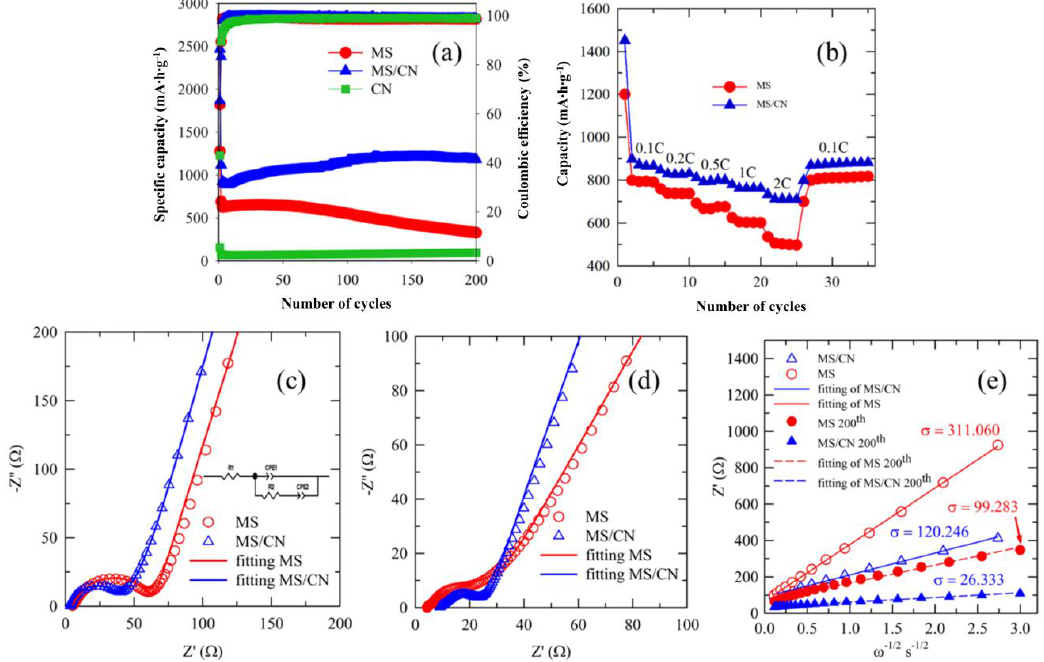
Figure 5. ( a ) Cycling performance, ( b ) rate performances, ( c ) Nyquist plots for the initial MS and MS/CN electrode, ( d ) Nyquist plots for the MS and MS/CN electrode after 200 cycles and ( e ) Warburg coefficient plots for the initial state and after 200 cycles of the MS and MS/CN